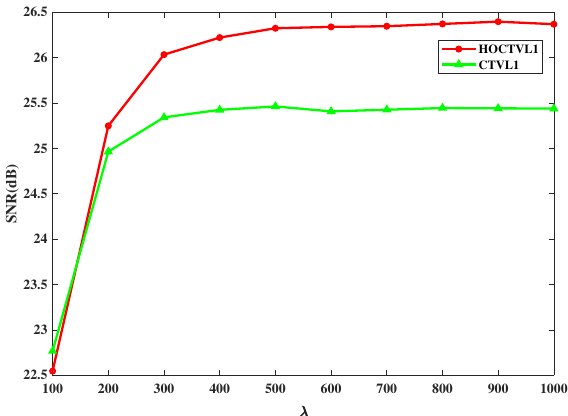
Figure 5. The SNR of HOCTVL1 and CTVL1 with different λ .